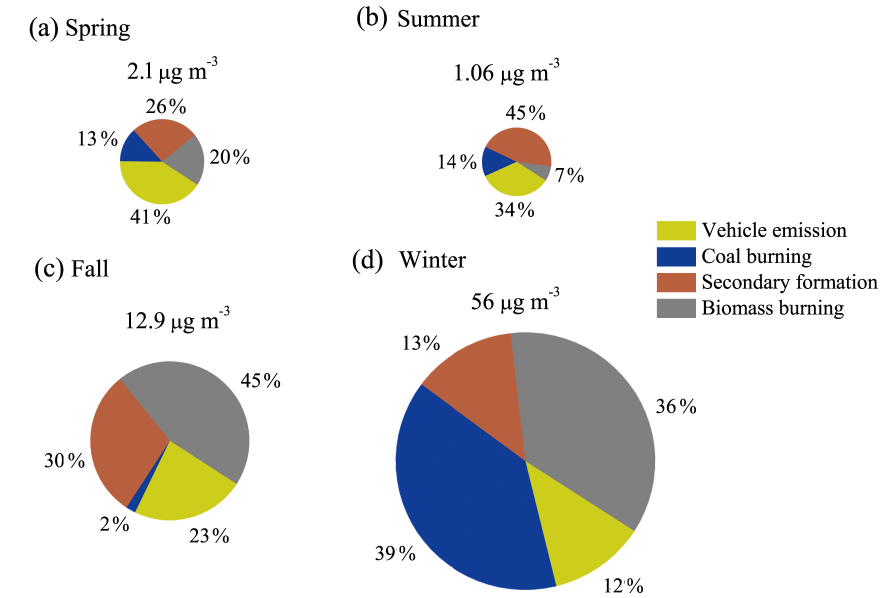
Figure 4. Contributions of source factors to the concentrations of NACs in four seasons.